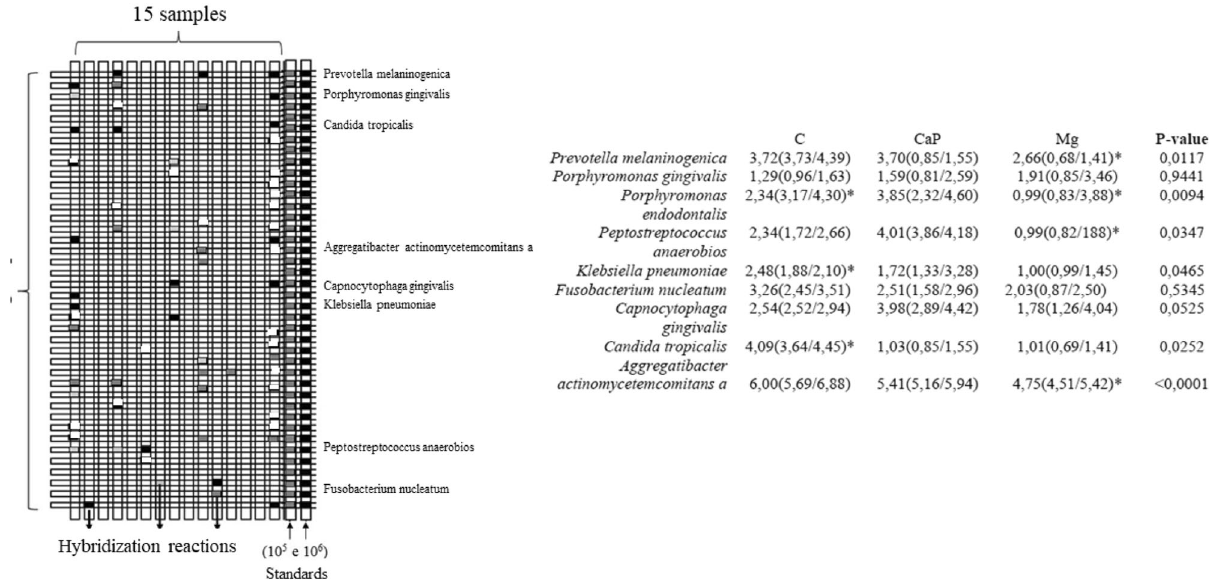
Fig. 4 Schematic drawing of membrane after revealing the hybridi- zation signals and medians ( fi rst/third quartiles) of microbial counts (×10 5 ) obtained by DNA-DNA Checkerboard hybridization technique